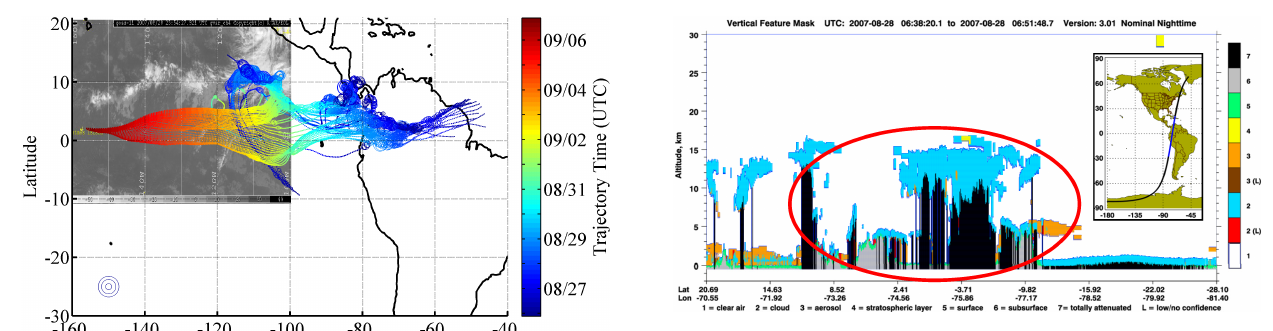
Fig. 11. As Fig. 8 but for case study II showing a CALIOP mask Fig. 11: As Figure 8 but for Case Study II showing a Fig. 11: As Figure 8 but for Case Study II showing a from 28 August, CALIOP mask from 28 August, 06:45 UTC. CALIOP mask from 28 August, 06:45 UTC. Fig. 10. As Fig. 7 but for case study II. Trajectories are overlaid on